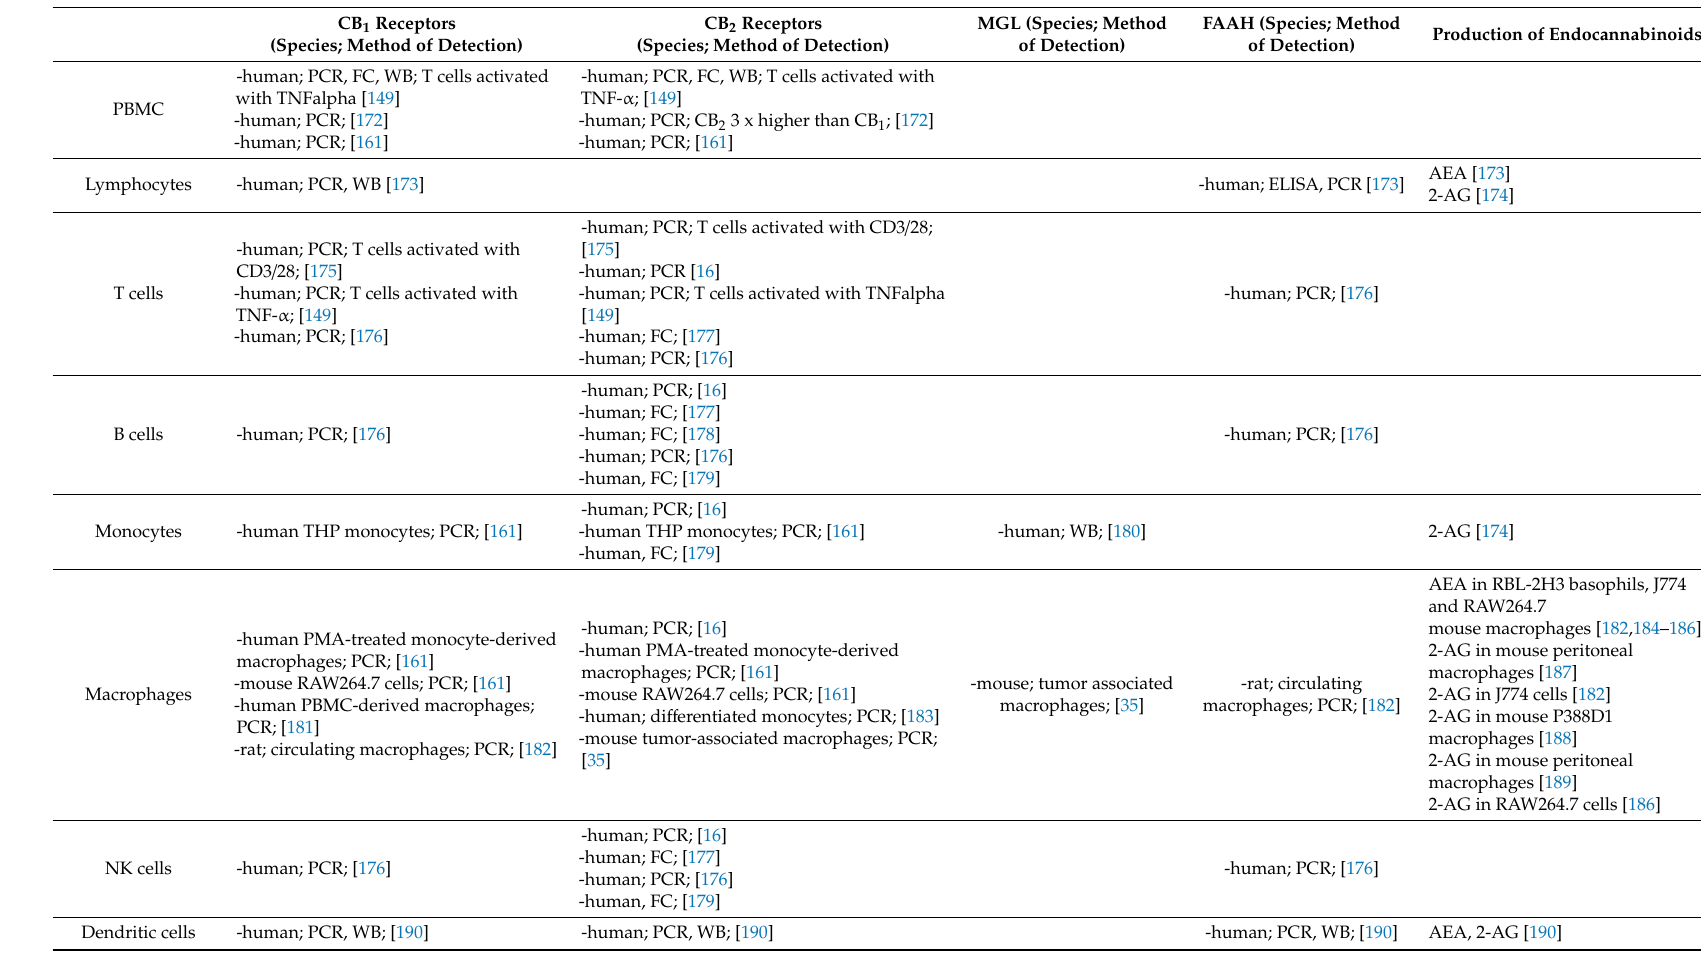
Table 2. The immune endocannabinoid